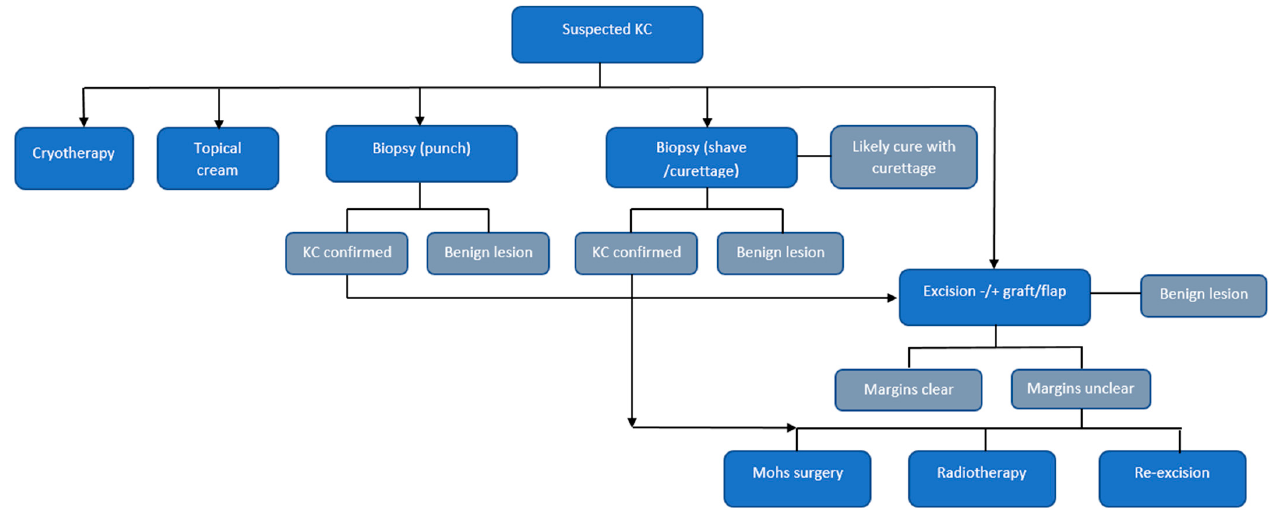
Figure 2. Main pathways for treatment of keratinocyte cancer. BCC/SCC have not been separated nor categorised by invasive, superficial, etc., because treatment is largely the same. Excision is the mainstay treatment modality. Radiotherapy is required if perineural invasion has occurred, performed in hospital, or for field treatment of multiple SCCs in the same area, e.g., forehead. Mohs surgery can be performed for an improved cosmetic outcome in a difficult facial area. Topical creams include imiquimod and 5-FU fluorouracil. GPs and skin cancer GPs perform much of the excisional treatments, whereas dermatologists and plastic surgeons treat more complex cases. A small proportion are referred to hospital dermatology departments where organ transplant recipients (as a very high-risk group) are also treated for skin cancers.